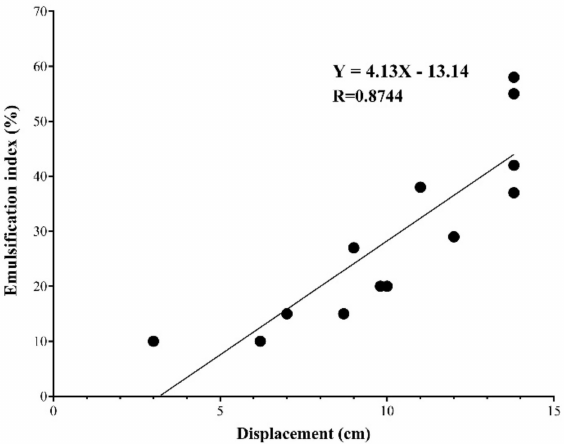
Figure 7. Correlation between emulsification index E24 and oil displacement (cm) (each point represents the average of three